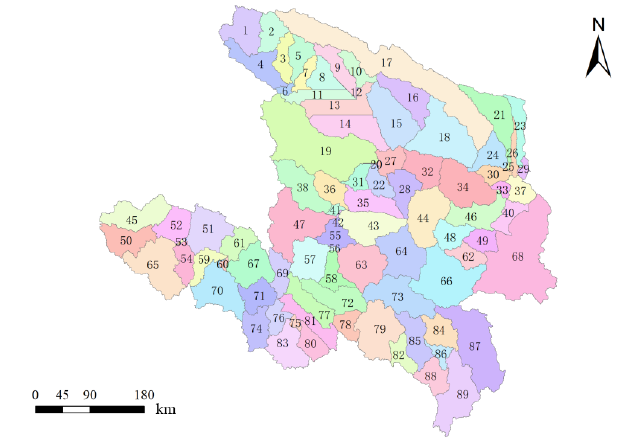
Figure 2. The number of every